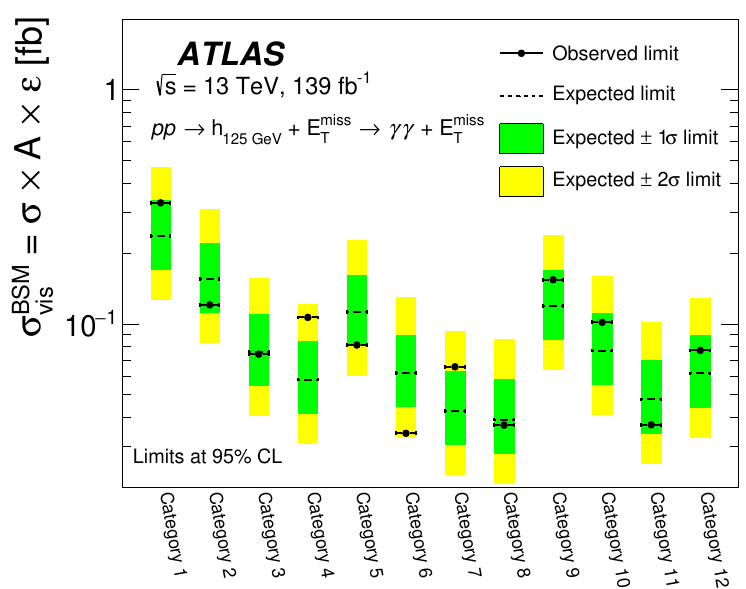
Figure 8 . The 95% CL model-independent upper limits computed from individual (cid:12)ts in each of 12 categories on the visible cross-section (cid:27) BSM BSM processes.